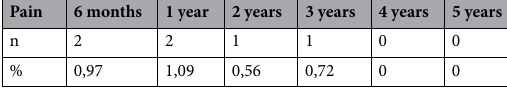
Table 7. Pain control follow-up.